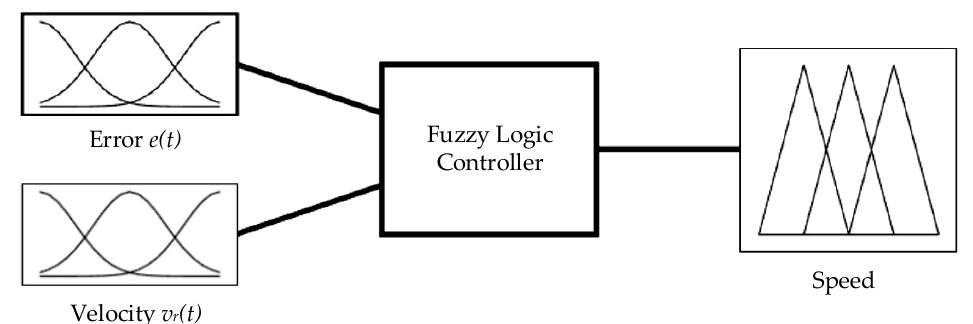
Figure 6. The fuzzy logic controller for pump control.